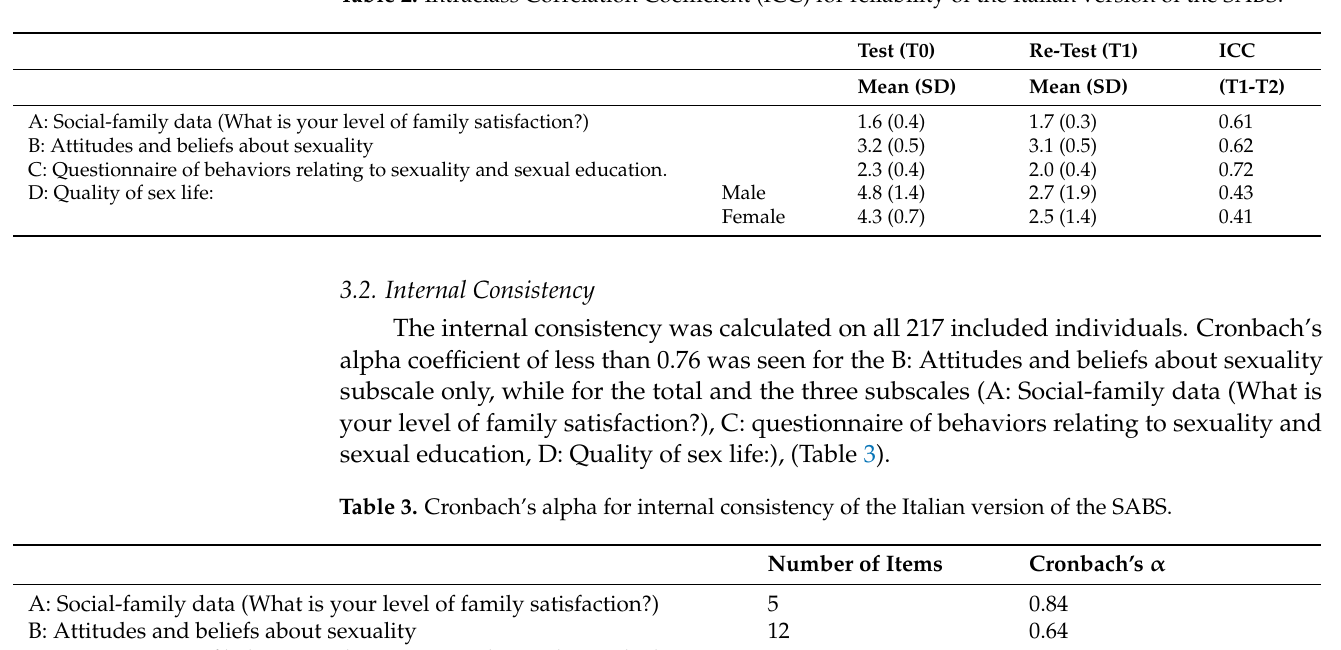
Table 2. Intraclass Correlation Coefficient (ICC) for reliability of the Italian version of the SABS.